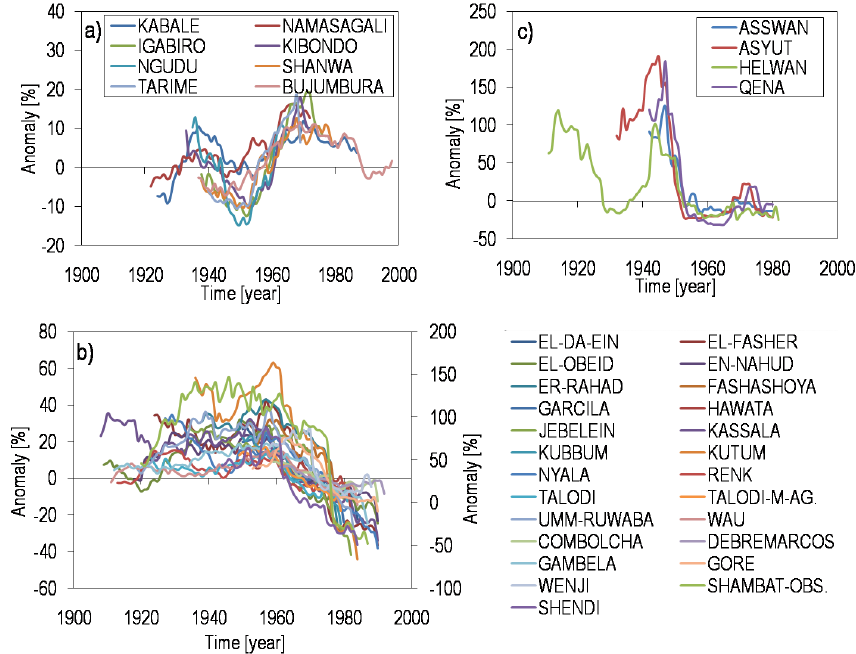
Figure 4. QPM results for annual rainfall using a time slice of 15 years and rainfall stations for group (a) A, (b) B, (c)